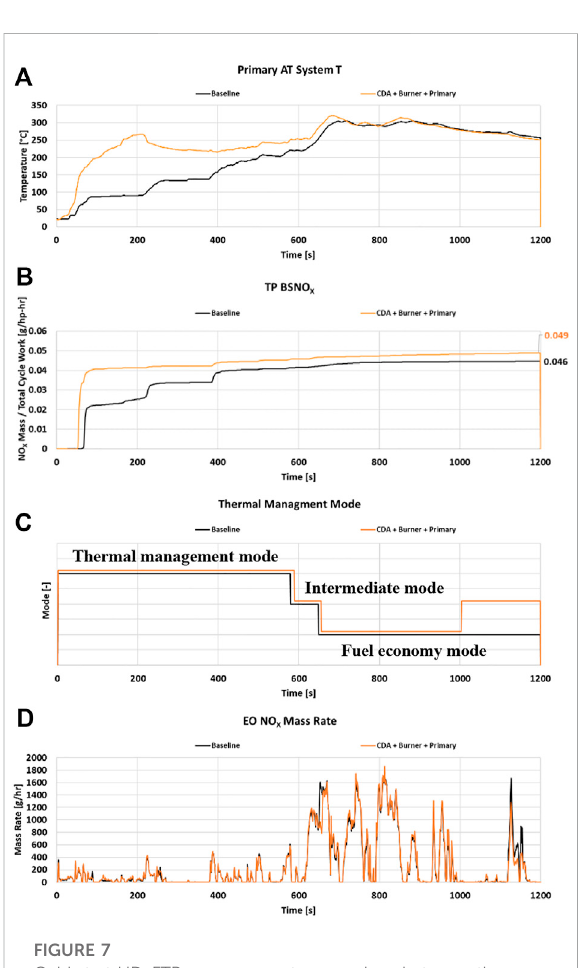
FIGURE 7 Cold start HD-FTP measurement comparison between the Baseline and the CDA + Burner + Primary systems. (A) Primary system temperature, (B) Cumulative TP BSNO X , (C) Engine mode comparison, (D) Engine outlet NO X mass